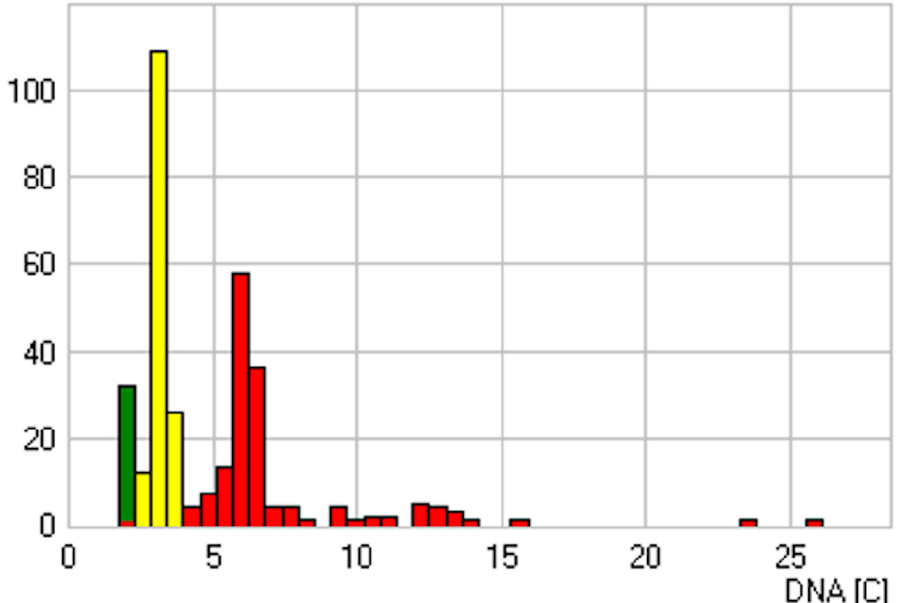
Figure 4. Sample with a positive cytological diagnosis and DNA aneuploidy as a sign of malignant transformation. Atypical stemline distribution at 3.24c and 6.5c. In addition, several cells with a DNA content >9c are shown. DNA content in c-units (x-axis), number of cells (y-axis), reference cells (green), analysis cells (red), biggest stemline (yellow). This sample is a carcinoma of the soft palate in a 68-year-old male patient.